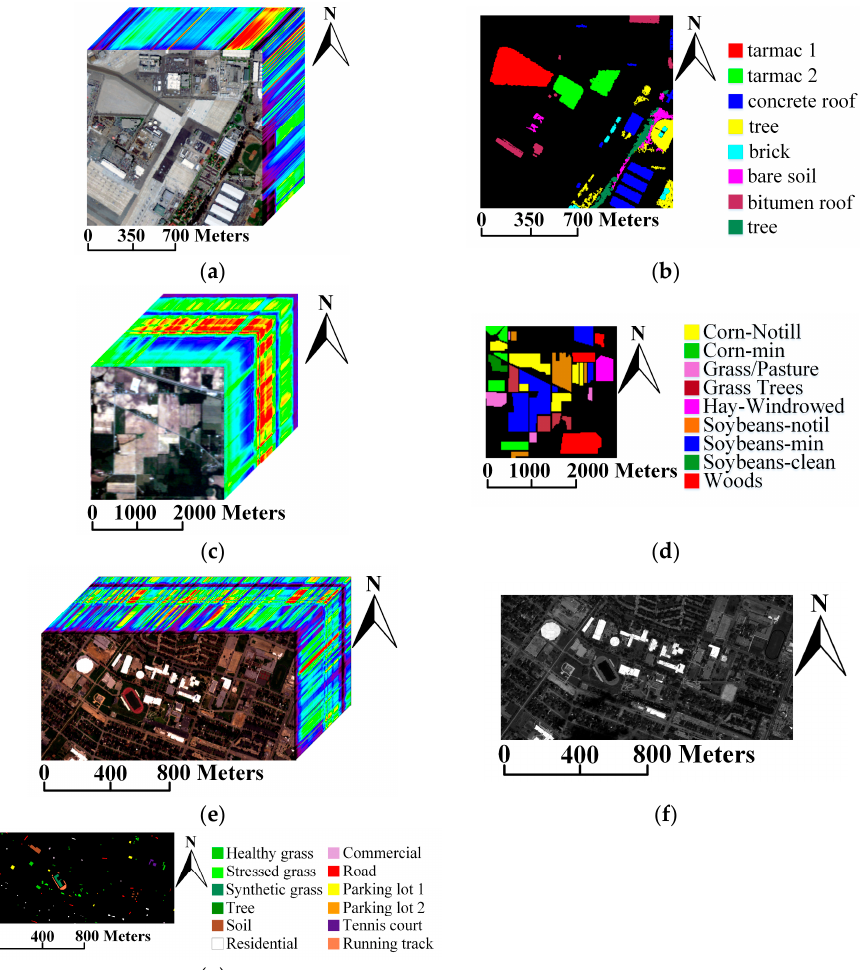
Figure 1. Experimental data sets. ( a ) The AVIRIS HS image over San Diego; ( b ) The ground truth image of San Diego; ( c ) The AVIRIS HS image over Indian Pines region; ( d ) The ground truth image of Indian Pines region; ( e ) The University of Houston campus HS image; ( f ) The PAN image; ( g ) The ground truth images of the University of Houston campus.